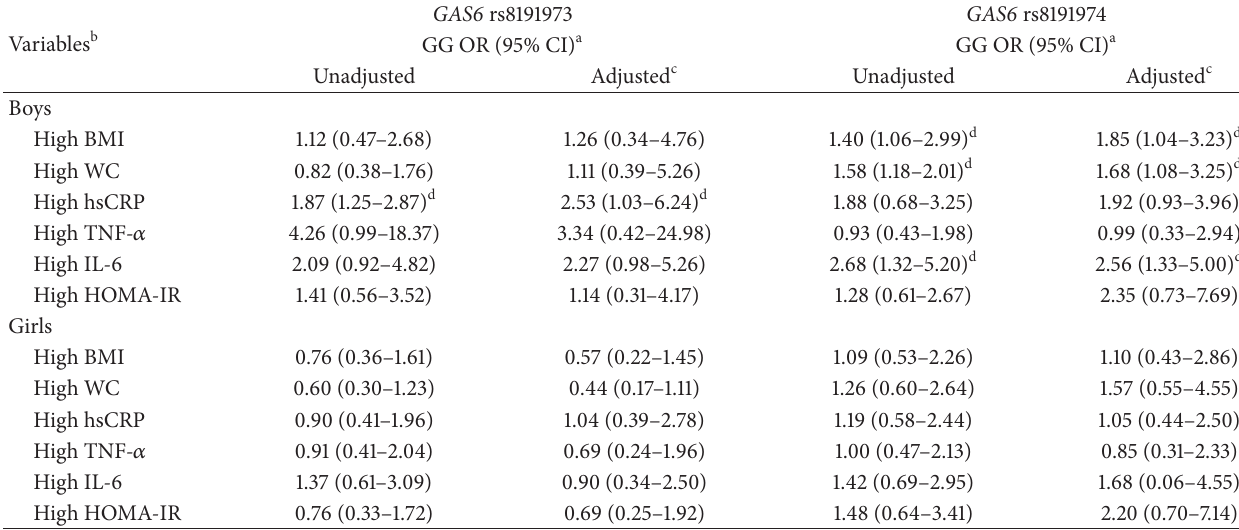
Table 5: Logistic regression analyses of different GAS6 SNP on abnormal variables among